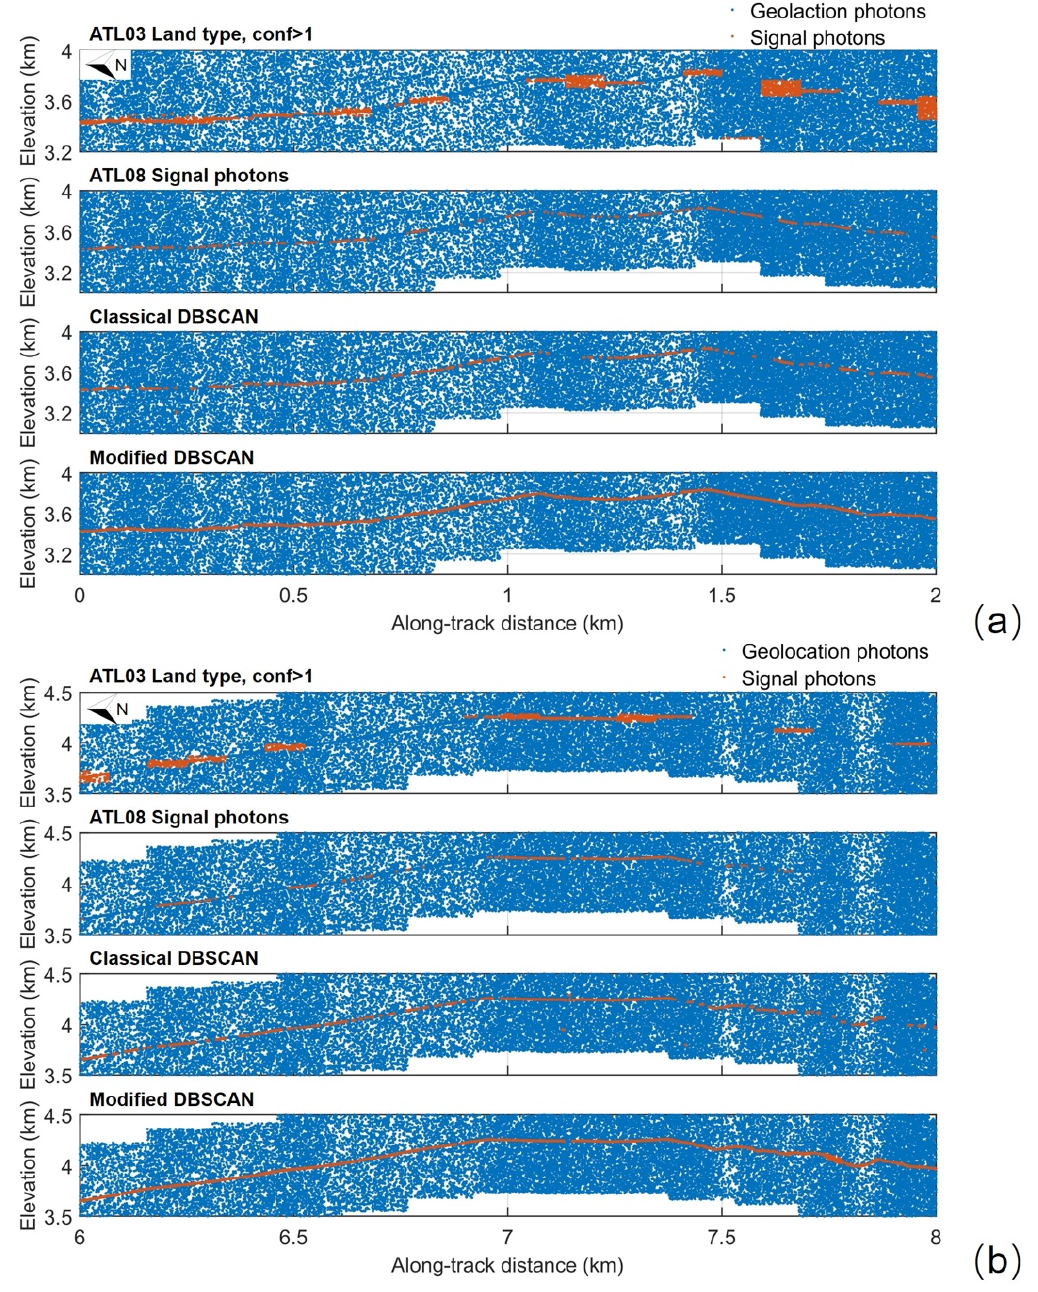
Figure A2. Detailed comparison of the results from different signal photon extraction methods in the second study area. ( a ) Enlarged along-track segment corresponding to the yellow box in Figure A1a at the along-track distance from 0 km to 2 km. ( b ) Enlarged along-track segment corresponding to the green box in Figure A1a at the along-track distance from 6 km to 8 km.